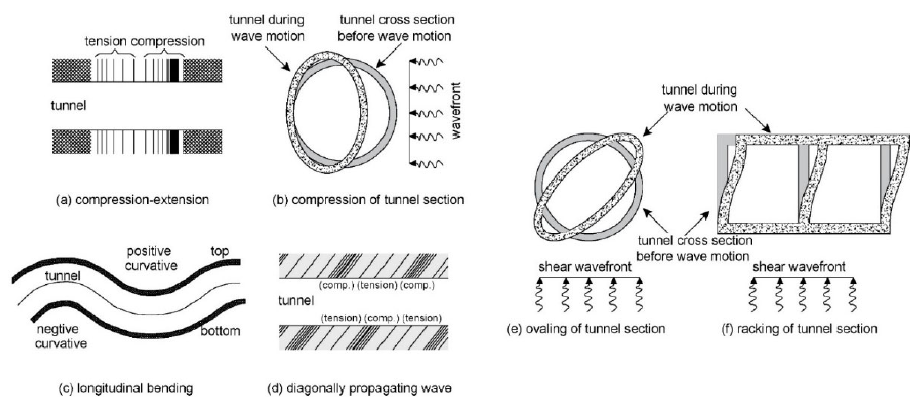
Figure 1. Underground structure deformation modes caused by earthquakes (after [57]).